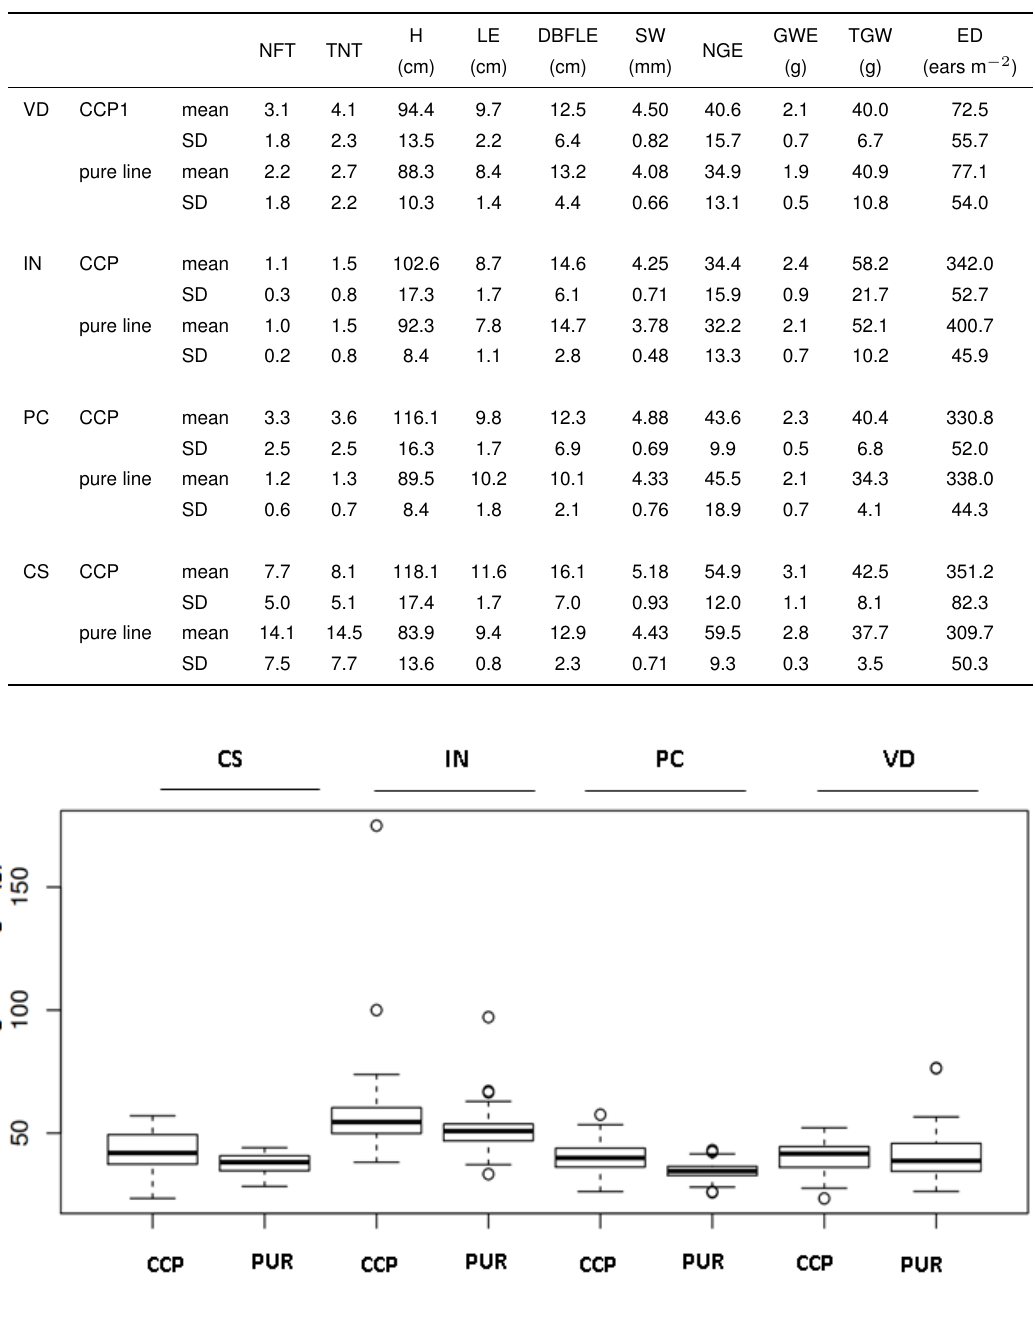
Table 2. Phenotypic trait means and standard deviations (SD) per farm and per wheat variety of ten plant parameters (see Table 3 for their description). Farms are arranged from the strongest to the weakest inter-plant competition environment. Means and SD are highlighted when significantly (p < 0.05) higher than corresponding variety means and SD within the same site. Per farm, varietal means were compared through one-factorial ANOVA accounting for blocks and SD were compared through a paired-samples t-test.